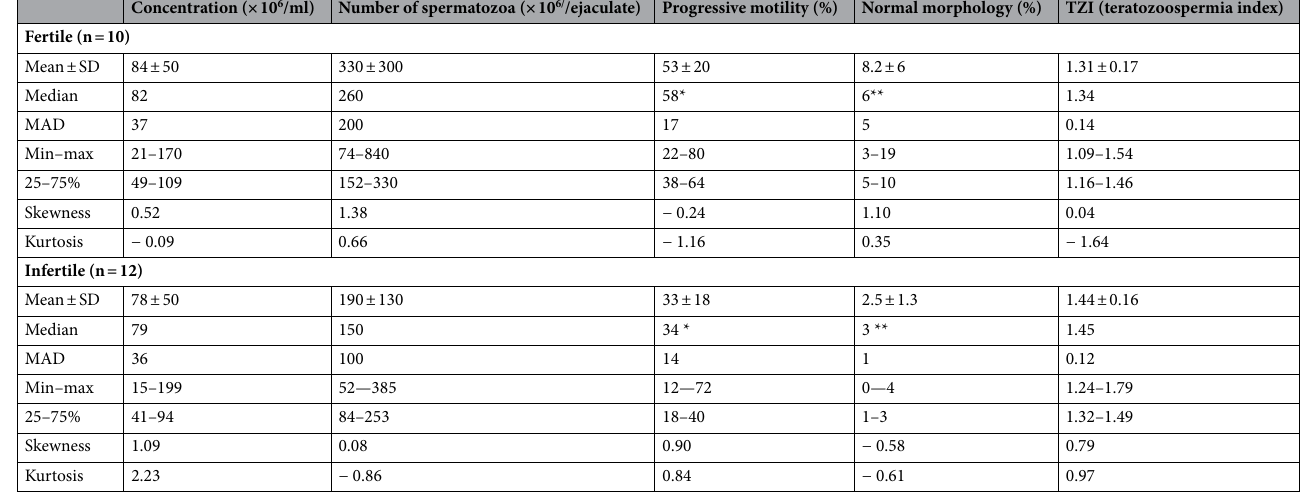
Table 1. Descriptive statistics and comparison of standard (WHO) semen parameters in analyzed fertile and infertile men. Statistically significant differences were observed for progressive motility in fertile vs progressive motility in infertile: * P < 0.03; normal forms in fertile vs normal forms in infertile: ** P <